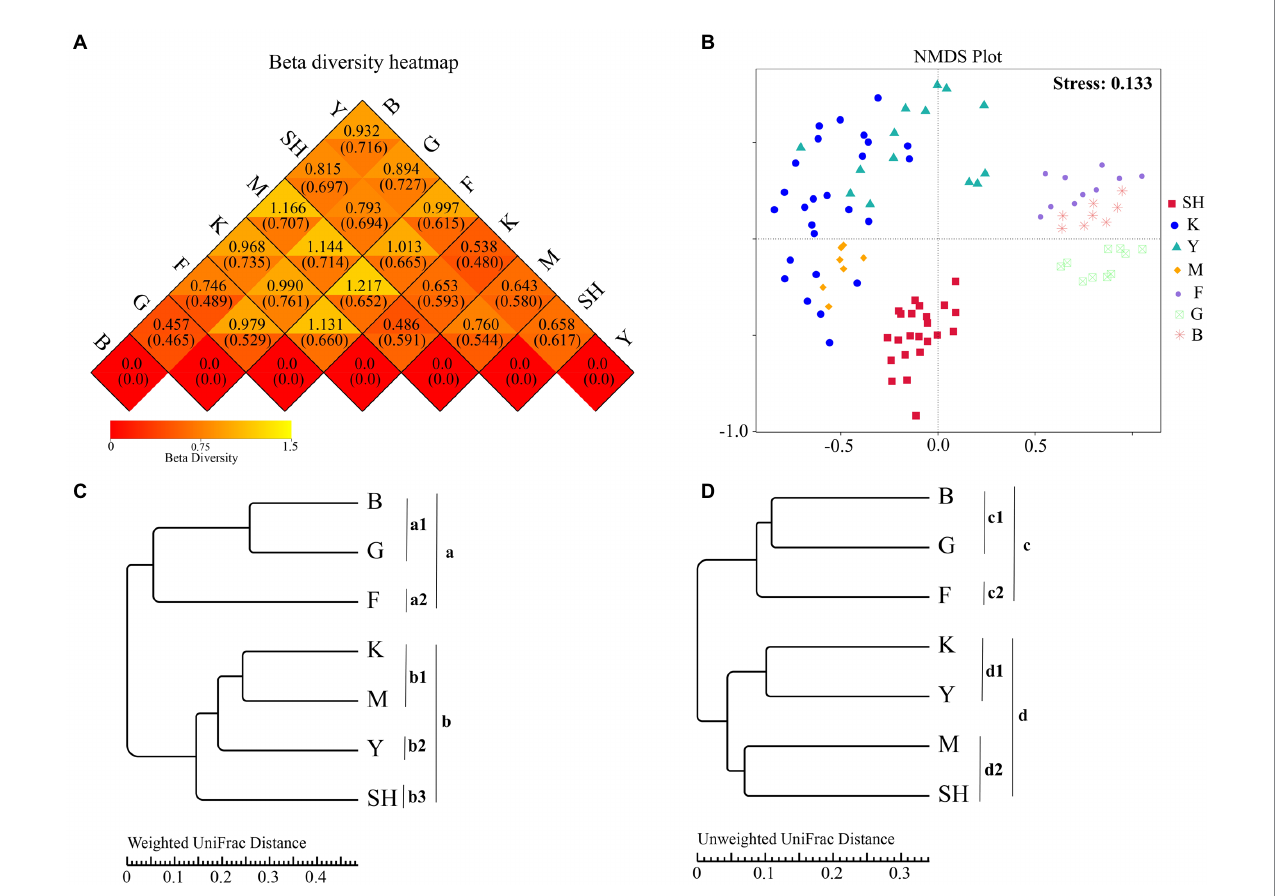
FIGURE 3 Beta diversity analyses (A) , heatmap of beta diversity index, (B) two-dimensional NMDS ordination, and (C) and (D) hierarchical clustering weighted UniFrac distance and Unweighted UniFrac distance of soil fungal communities inferred from ITS-2 rRNA gene at the phylum level for all seven sampling locations based on the Bray-Curtis distance, respectively. A closer distance on the NMDS graph indicates a more similar OTU composition. Abbreviations of variables are given in Figure